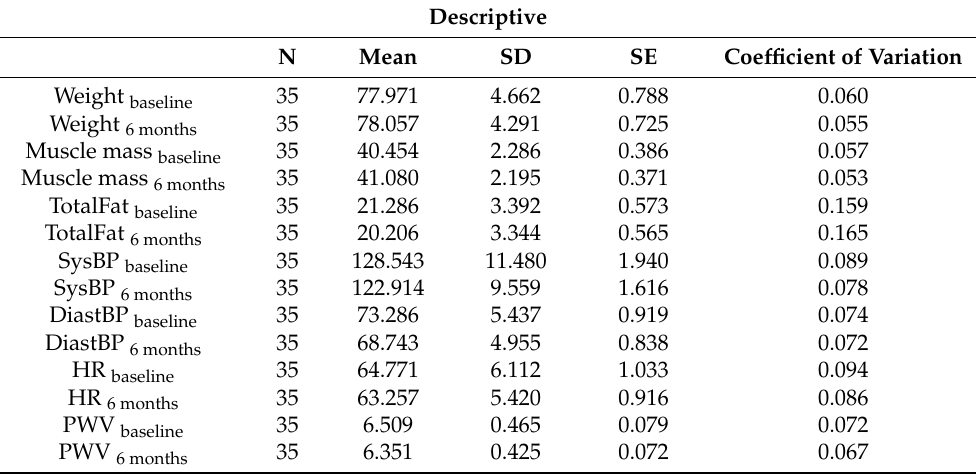
Table 4. Descriptive characteristics of patients in the arginine group at baseline and six